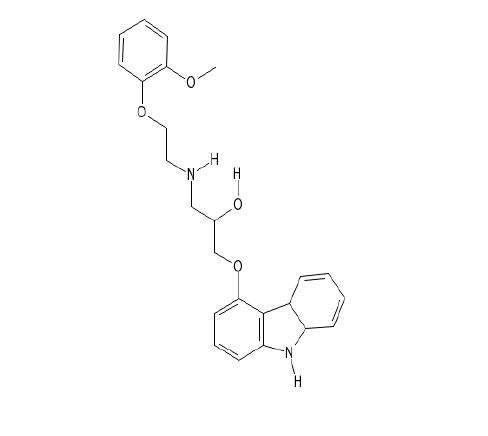
Figure 1. Structure of